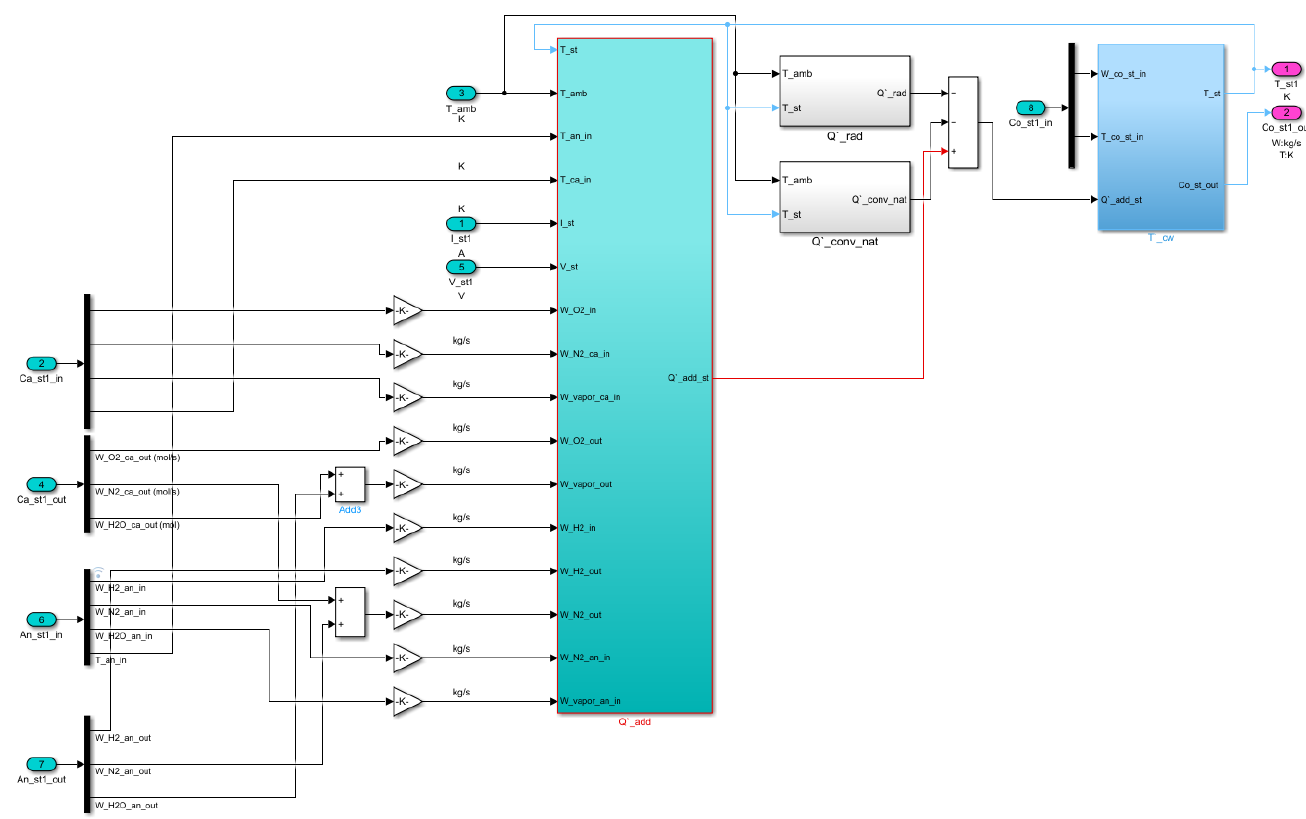
Figure 13. The input and output of the stack temperature model.